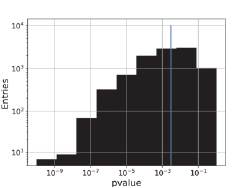
Figure 6: The distributions of p-value at 50 events